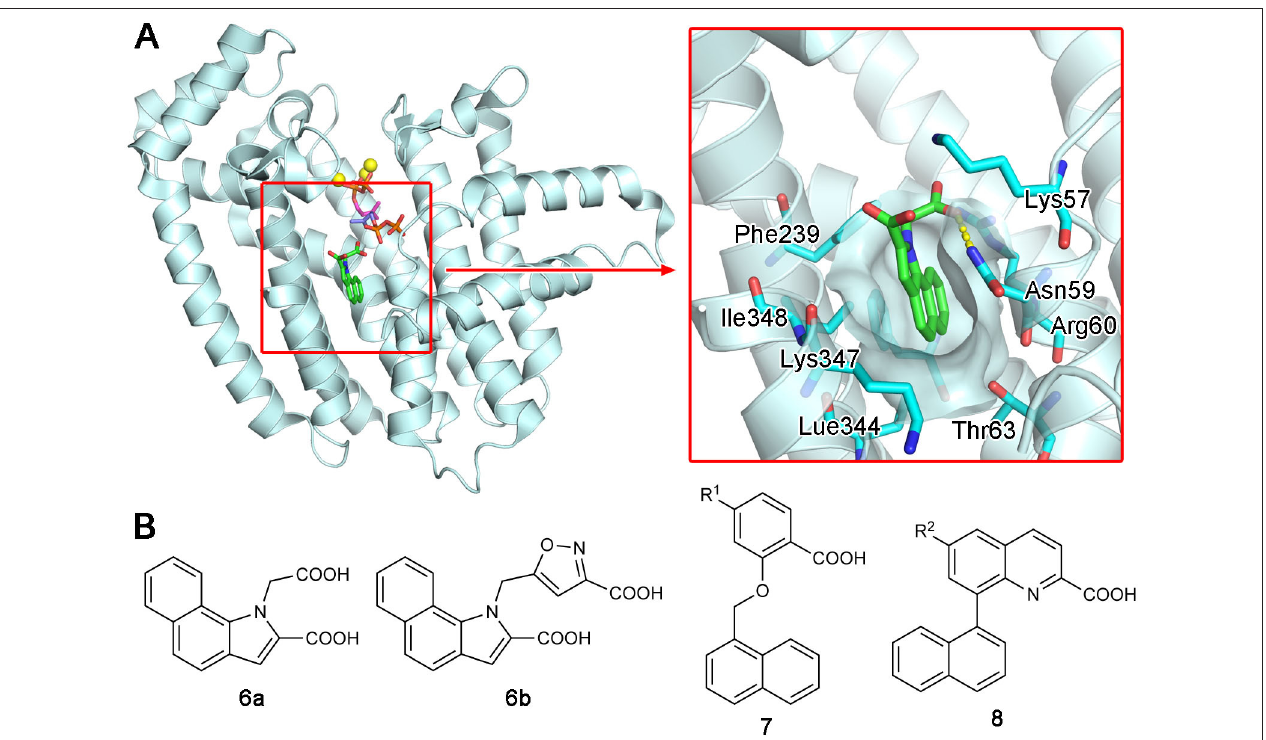
FIGURE 6 | Discovery of non-bisphosphonate hFPPS inhibitors. (A) The binding of inhibitor 6a (green; see panel B for its molecular structure) to the new druggable pocket of hFPPS (PDB ID: 3N6K). To provide a reference point, the binding sites for DMAPP (magenta), IPP (purple), and Mg 2 + ions (yellow) are indicated in the overall structure via superposition. (B) Structures of non-bisphosphonate inhibitors of hFPPS. R 1 and R 2 in compounds 7 and 8 represent very broadly defined substituents, including hydrogen, halogen, and optionally substituted heterocyclic groups.